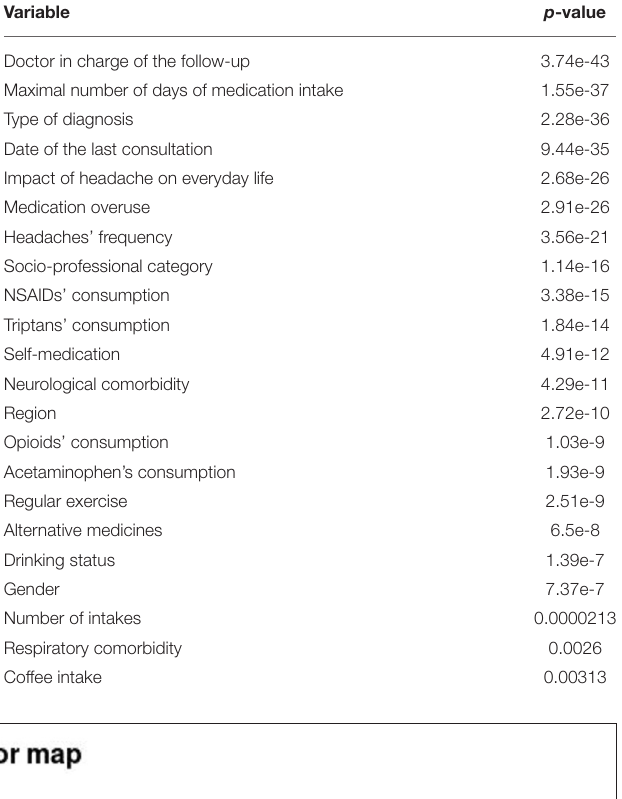
TABLE 4 | Variables ranked by order of importance for clustering.